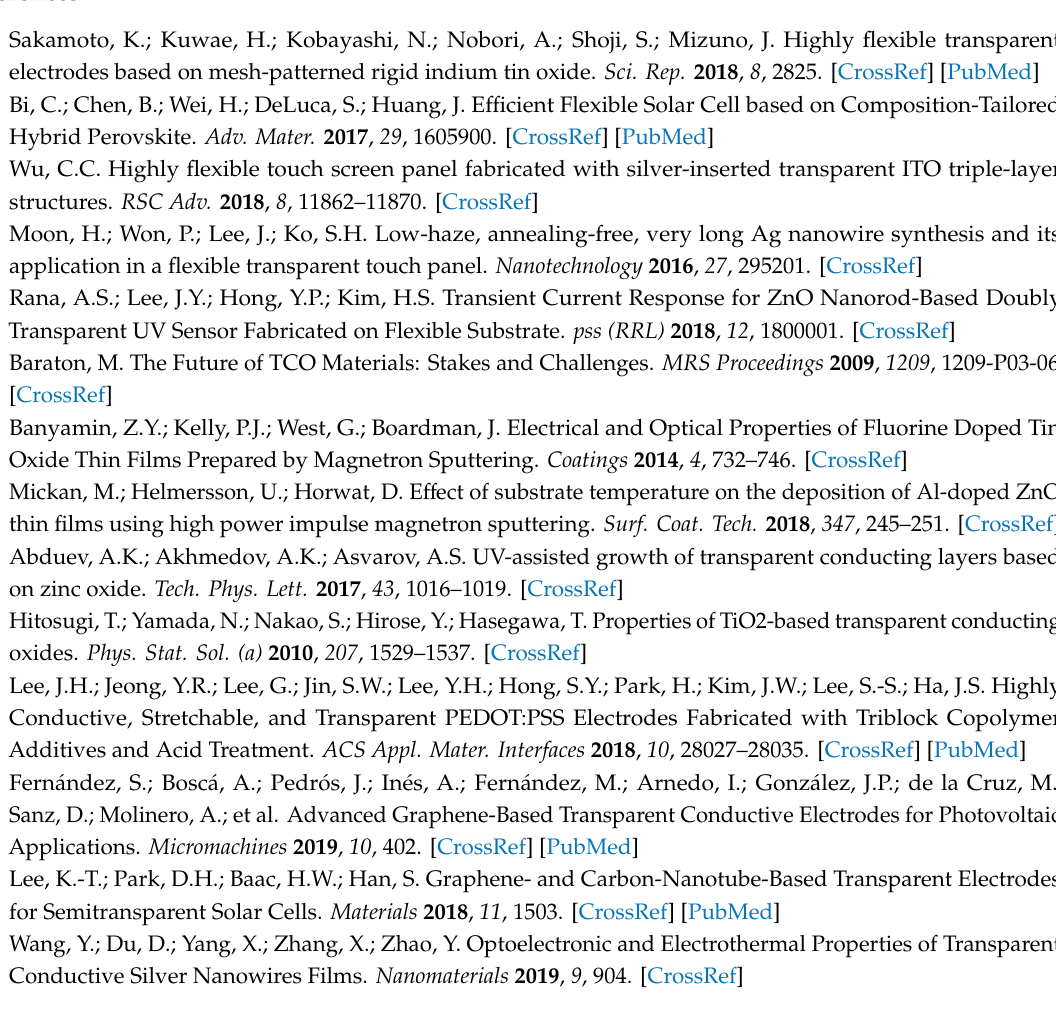
Figure S1: Cross-sectional SEM images of the GAG-3 (a) and GAG-4 (b) trilayer structures, Figure S2: AFM images (2 × 2 µ m 2 ) prepared in semi-contact mode for GAG-0 (a), GAG-1 (b), GAG-3 (c), GAG-4 (d), GAG-5 (e), and GAG-6 (f), Figure S3: GAG-3 XRD plot in comparison with XRD spectra of pure bulk Ag and pure bulk ZnO